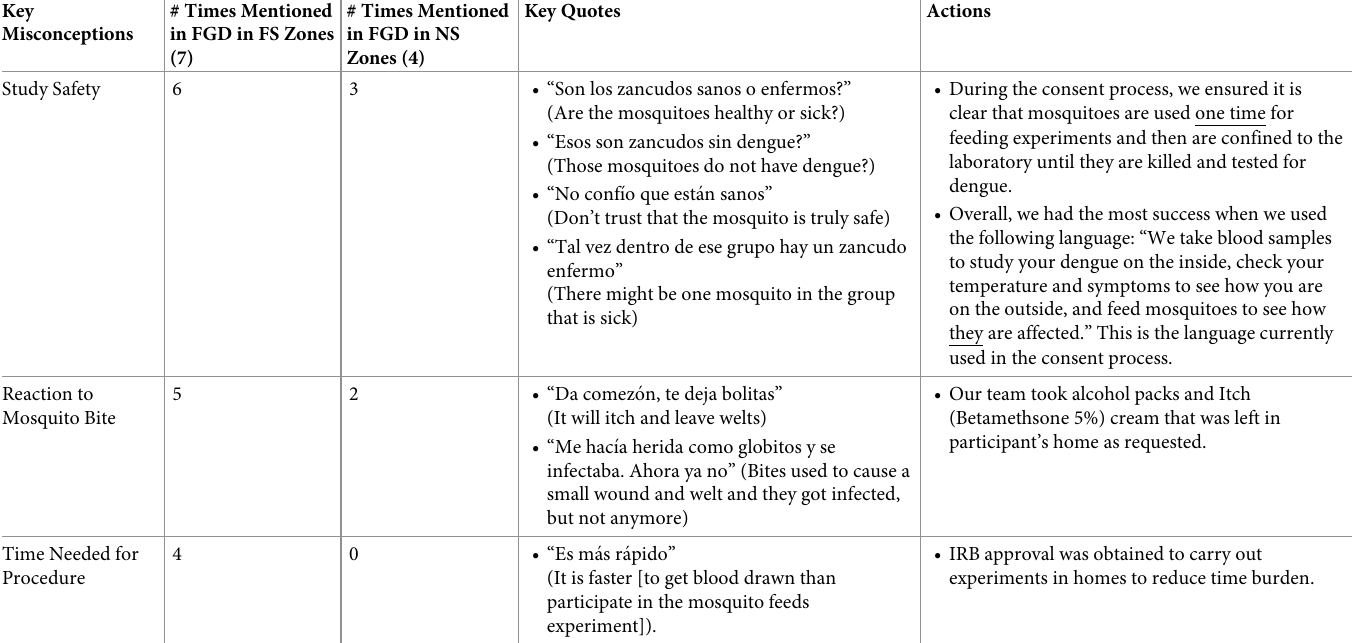
Table 2. How key misconceptions identified in focus group discussions translated to changes in research protocol for direct mosquito feeding experiments carried out on DENV-infected people. Key